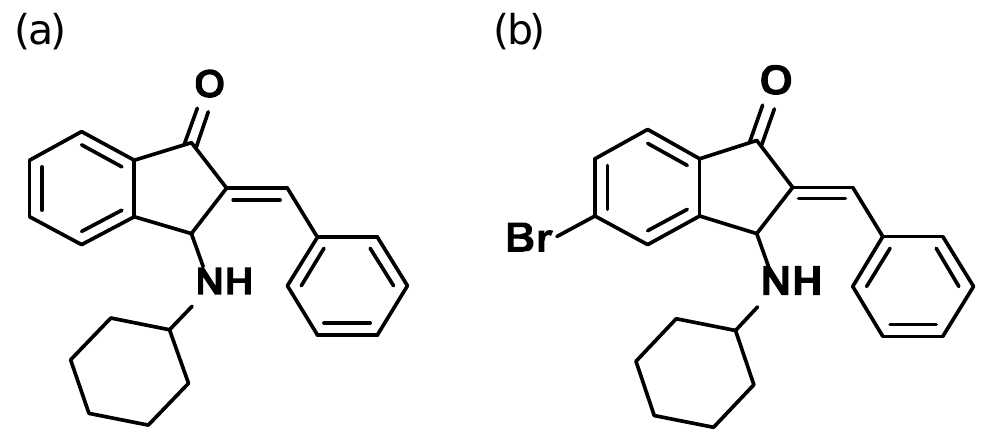
Figure 1. Chemical structure of BCI-215. Chemical structure of ( a ) BCI (CAS#: 1245792-51-1) and ( b ) BCI-215 (CAS#: 1245792-67-9).